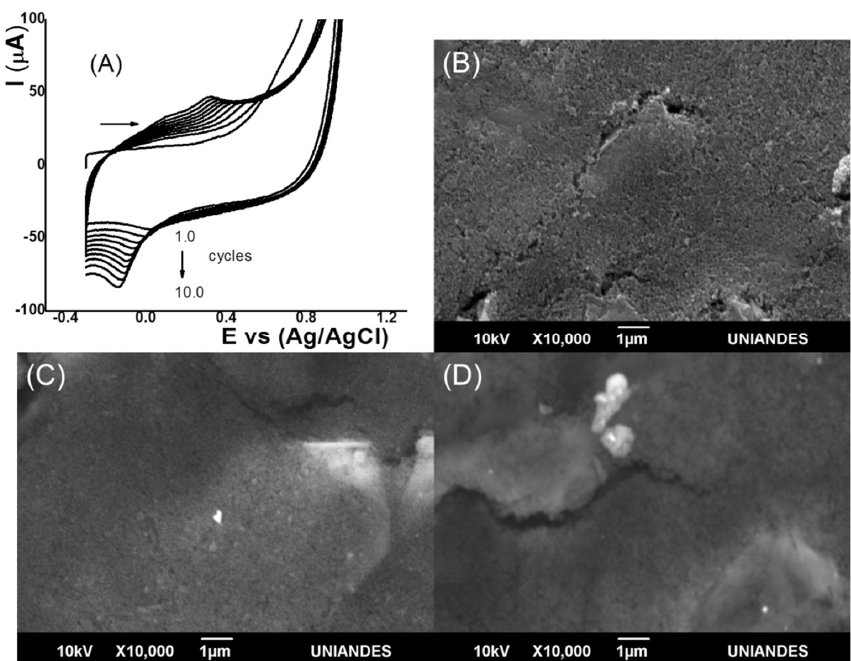
Figure 1. ( A ) Preparation of electromodified screen‐printed carbon (SPC) electrode by cyclic voltammogram (CV) (10 cycles) and scanning electron microscopy (SEM) images of the ( B ) SPC, ( C ) chitosan (CS)/SPC electrodes, and ( D ) ionic liquid (IL)‐CS/SPC.